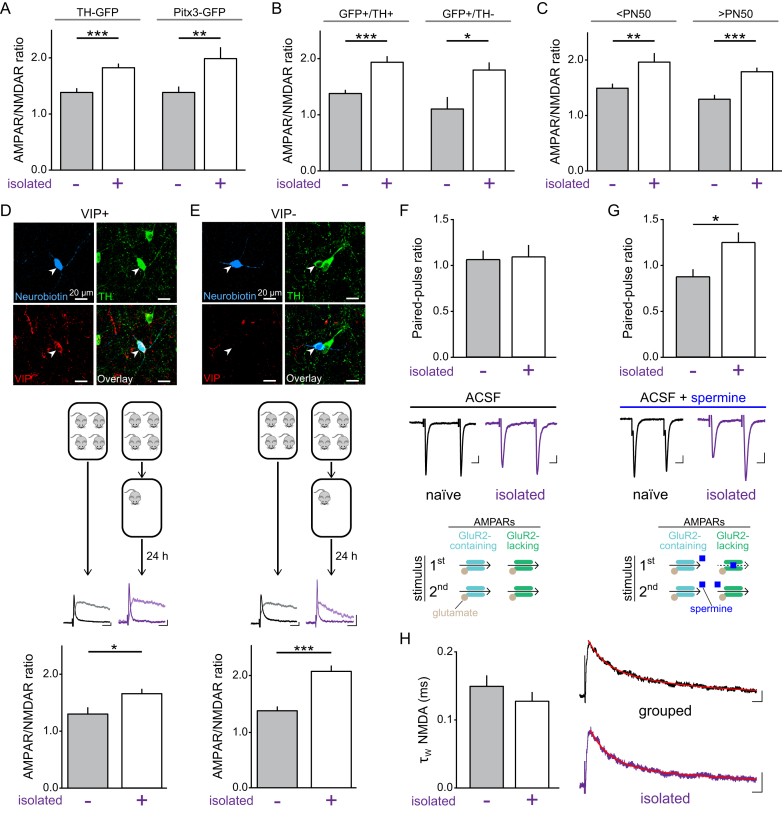
Electrophysiological Measures of AMPAR and NMDAR Current Properties in DRN DA Neurons of Group-Housed and Socially Isolated Mice, Related to Figure 1(A) AMPAR/NMDAR ratios recorded in DRN DA neurons from both TH-GFP and Pitx3-GFP mice showed a significant increase following 24 hr social isolation in comparison to group-housed mice (TH-GFP – unpaired t test: t48 = 4.100, ∗∗∗p = 0.0002; n = 25 grouped, 25 isolated; Pitx3-GFP – unpaired t test: t27 = 2.813, ∗∗p = 0.0090; n = 17 grouped, 12 isolated).(B) AMPAR/NMDAR ratios recorded from GFP+/TH+ and GFP+/TH- DRN neurons, in both transgenic mouse lines, were significantly greater in socially isolated compared with group-housed mice (GFP+/TH+: unpaired t test: t46 = 4.149, ∗∗∗p = 0.0001; n = 23 grouped, 25 isolated; GFP+/TH-: unpaired t test: t8 = 2.695, ∗p = 0.0273; n = 5 grouped, 5 isolated).(C) Both adolescent (< PN50) and adult (> PN50) mice showed a significant increase in the AMPAR/NMDAR ratio following social isolation (< PN50 – unpaired t test: t40 = 3.011, ∗∗p = 0.0045; n = 23 grouped, 19 isolated; ≥ PN50 – unpaired t test: t33 = 4.226, ∗∗∗p = 0.0002; n = 18 grouped, 17 isolated).(D and E) Example high-magnification confocal images of neurobiotin-filled (blue) neurons immunohistochemically identified as TH+ (green) and (D) VIP+ (red) or (E) VIP−. Illustration of mouse housing manipulations, example AMPAR/NMDAR ratios recorded in DRN DA neurons, and bar charts showing the mean ratio for each condition. Both VIP+ and VIP− DRN DA neurons showed a significantly greater AMPAR/NMDAR ratio following social isolation (VIP+: unpaired t test: t18 = 2.210, ∗p = 0.0403; n = 10 grouped, 10 isolated; VIP−: unpaired t test: t36 = 4.78, ∗∗∗p < 0.0001; n = 18 grouped, 20 isolated). Scale bars, 20 pA, 20 ms.(F) In ACSF, the AMPAR PPR was not significantly different between naive (n = 14) and socially isolated mice (n = 11; unpaired t test: t23 = 0.0441, p = 0.952).(G) In the presence of the polyamine spermine, the AMPAR PPR was significantly greater in socially isolated relative to naive mice (unpaired t test: t31 = 2.269, ∗p = 0.0304, n = 11 naive, 22 isolated). Scale bars, 10 pA, 10 ms.(H) The decay phase of the NMDAR current was fitted with a double exponential function to calculate the weighted decay time constant (τW). No significant difference was found in the decay time constant of the NMDAR current between group-housed and socially isolated mice (Mann-Whitney U = 248, p = 0.7002, n = 28 grouped, 19 isolated). Scale bars, 20 pA, 20 ms.Data are represented as mean + SEM.